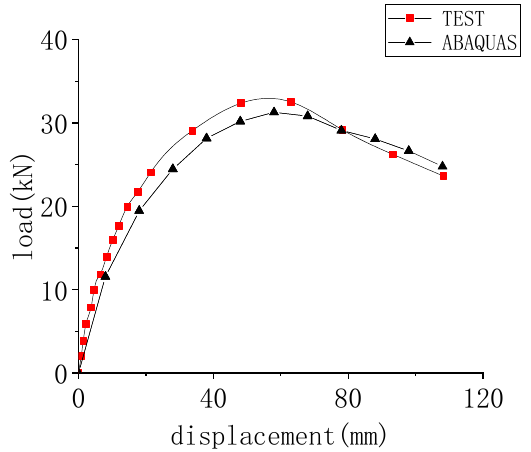
Figure 10. Comparison of skeleton curves of SRC-RC1 specimen. Table 4. Comparison of test and simulation parameters for SRC-RC1 specimens.